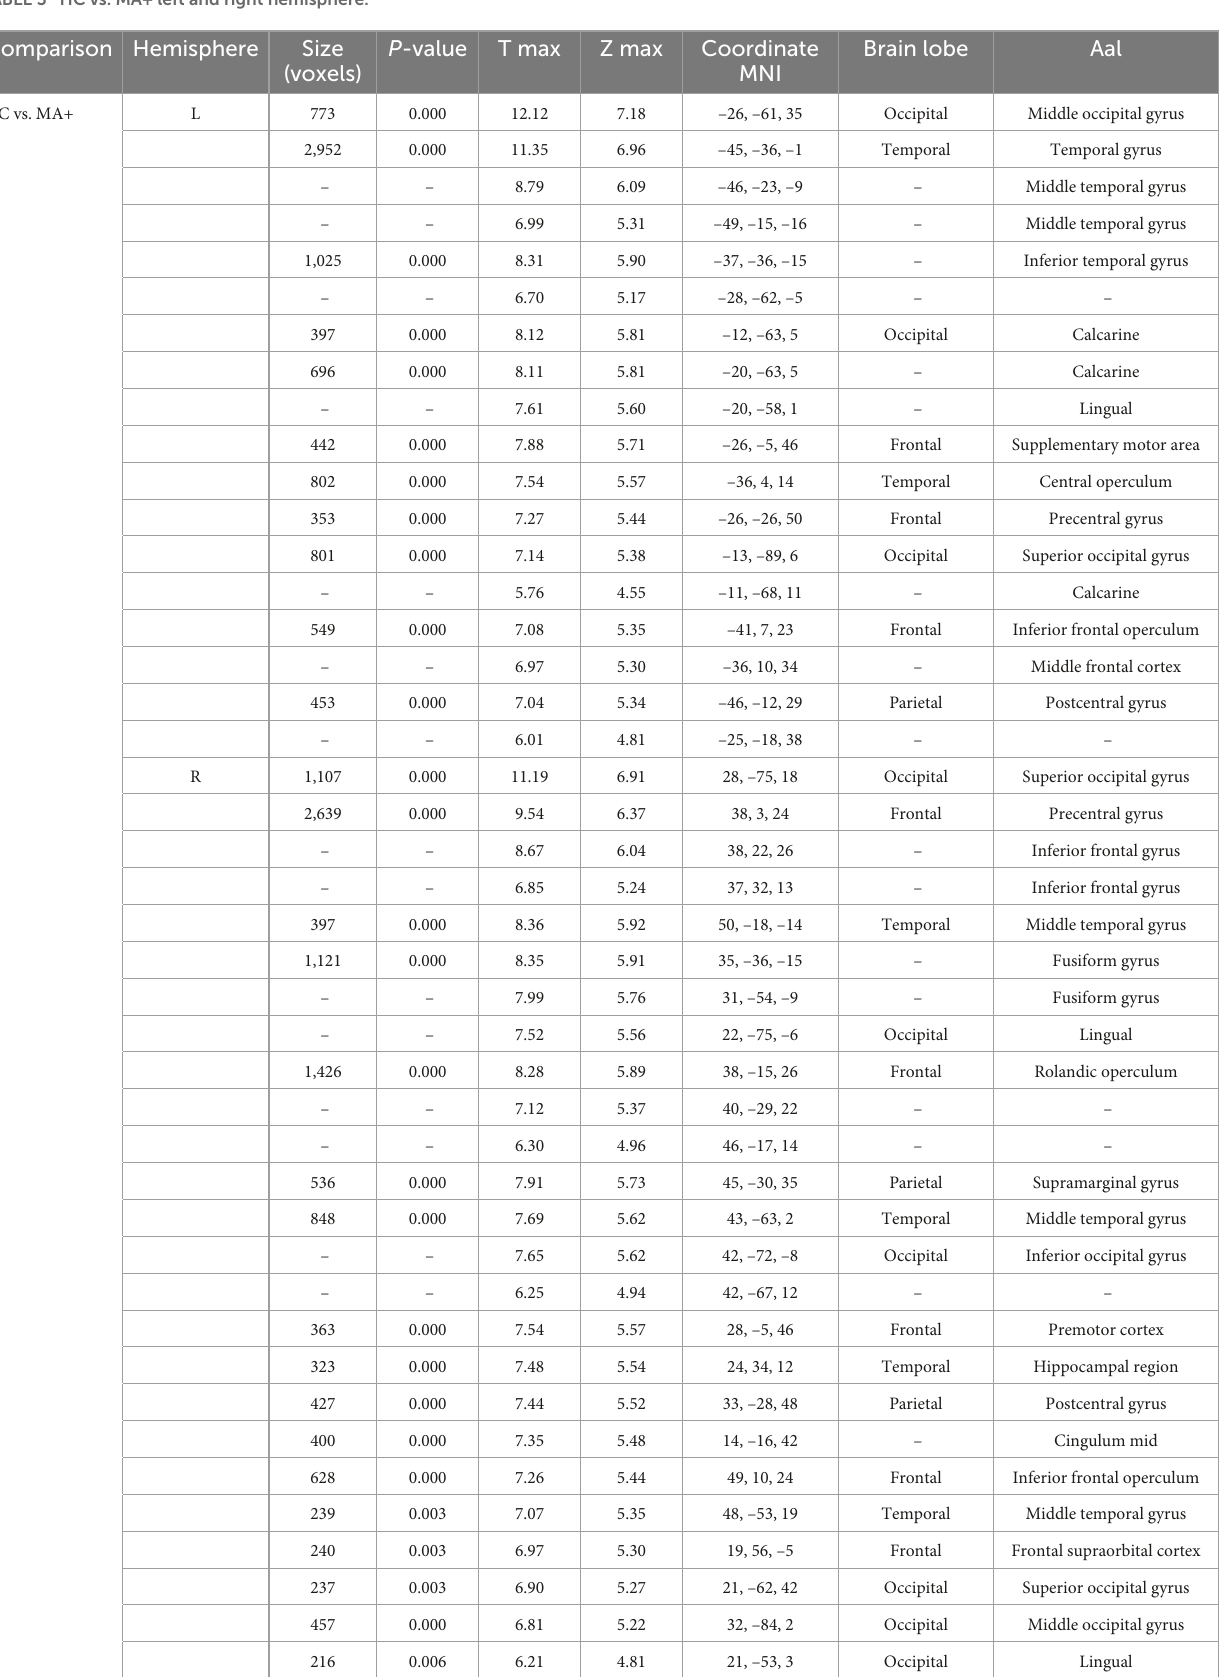
TABLE 3 HC vs. MA+ left and right hemisphere. Comparison